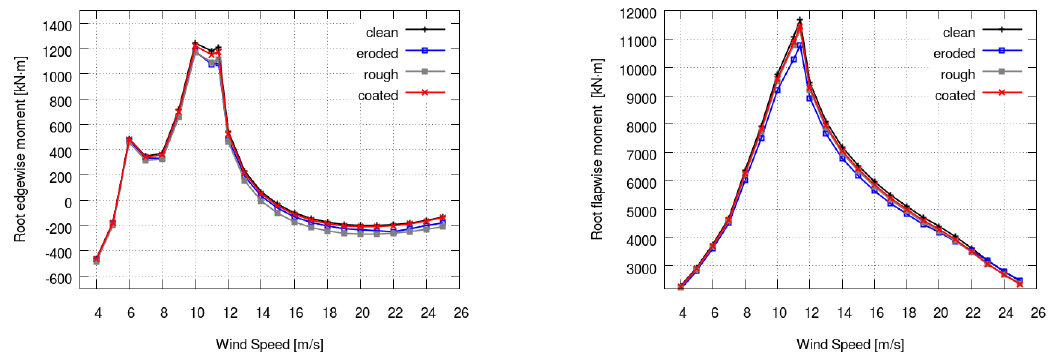
Figure 11. Edgewise and flapwise moments at the root for one blade of the NREL 5 MW turbine using different sets of polars for the NACA 64-618 airfoil.